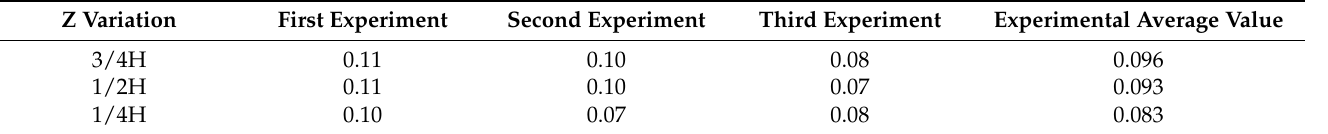
Table 1. Bearing outer ring elliptical deformation measurement results in the experiment